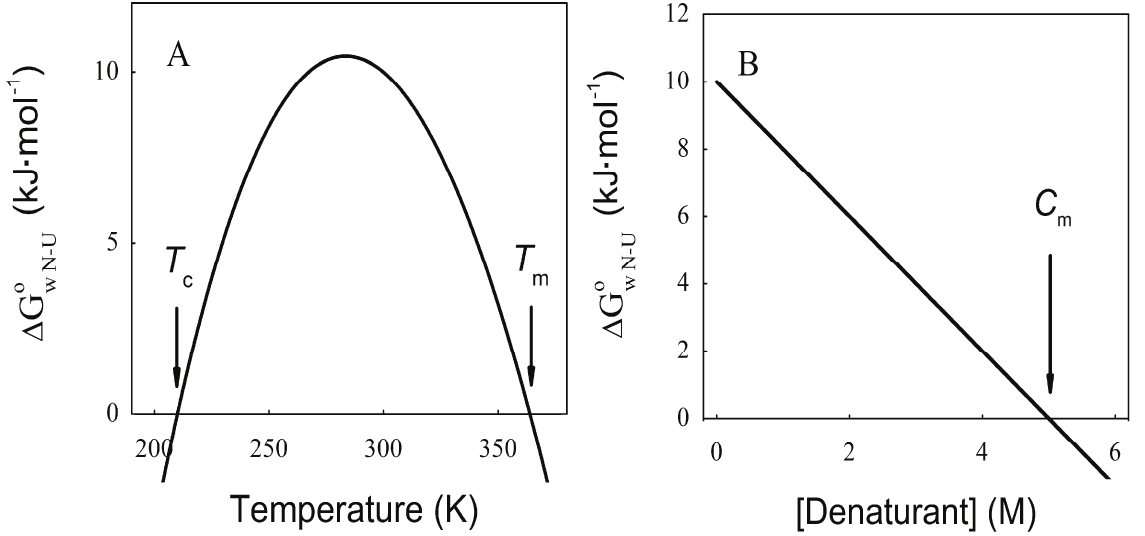
Figure 1. Dependence of the protein folding equilibrium on temperature and the presence of ° reaching a maximum value which corresponds denaturants. ( A ) Temperatures modify (cid:4)G w N(cid:5)U to the maximal protein stability. Heating or cooling the sample will lead to a decrease in (cid:4)G ° which will equal zero at the temperature of cold unfolding ( T ) and at the melting w N(cid:5)U c ). At both temperatures half the protein population is folded and the other temperature ( T m half is unfolded; ( B ) Protein stability decrease following a linear function of the concentration ° reaches the zero value at the mid-denaturant concentration of the chaotropic agent. (cid:4)G w N(cid:5)U ) where 50% of the population is folded and the other 50% is ( C m